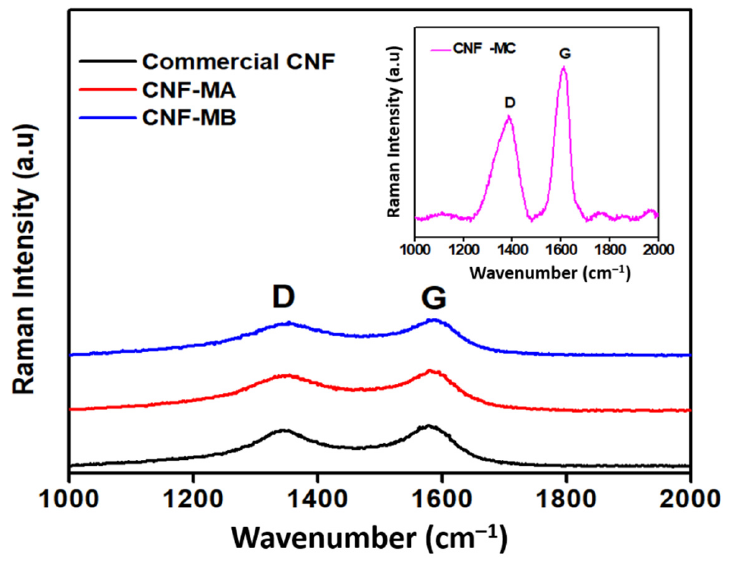
Figure 5. Raman spectra of the commercial CNF, CNF-MA, and CNF-MB samples; insert figure is the Raman spectra of CNF ‐ MC. Table 4. The I D /I G ratio of the commercial CNF and surface ‐ oxidised CNF samples. Sample